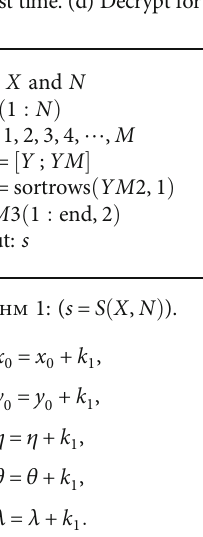
Figure 4: Visualization for Barbara. (a) First encryption. (b) Second encryption. (c) Decrypt for the fi rst time. (d) Decrypt for the second